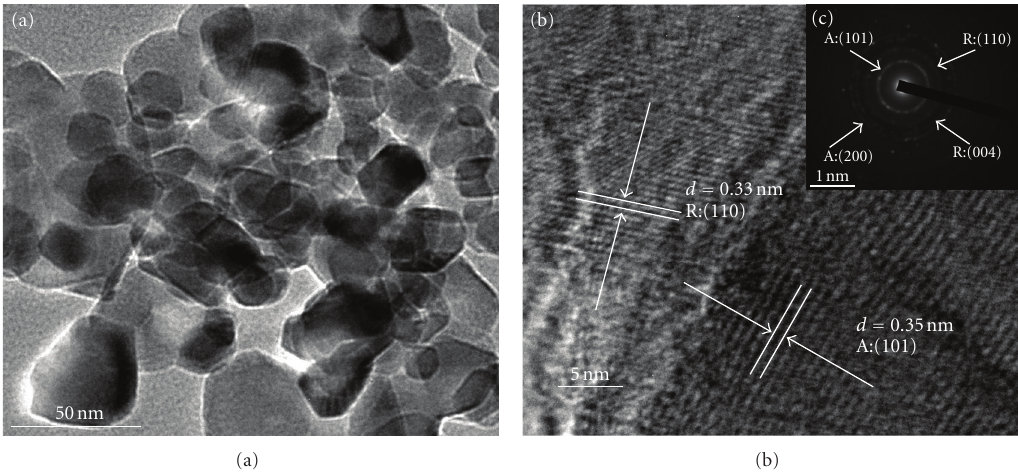
Figure 8: TEM (a) and HRTEM (b) images and SAED pattern (inset in (b)) of the TiO 2 samples calcined at 500 ◦ C for 4h.